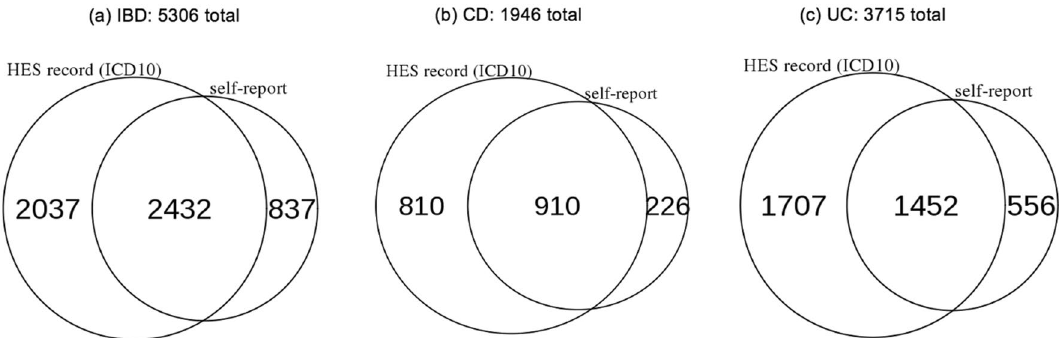
Figure 1. Number of IBD cases in the UK Biobank based on method of identification. ICD10-coded diagnoses were recorded in hospital episode statistics (HES) while self-reported conditions were gathered by survey at